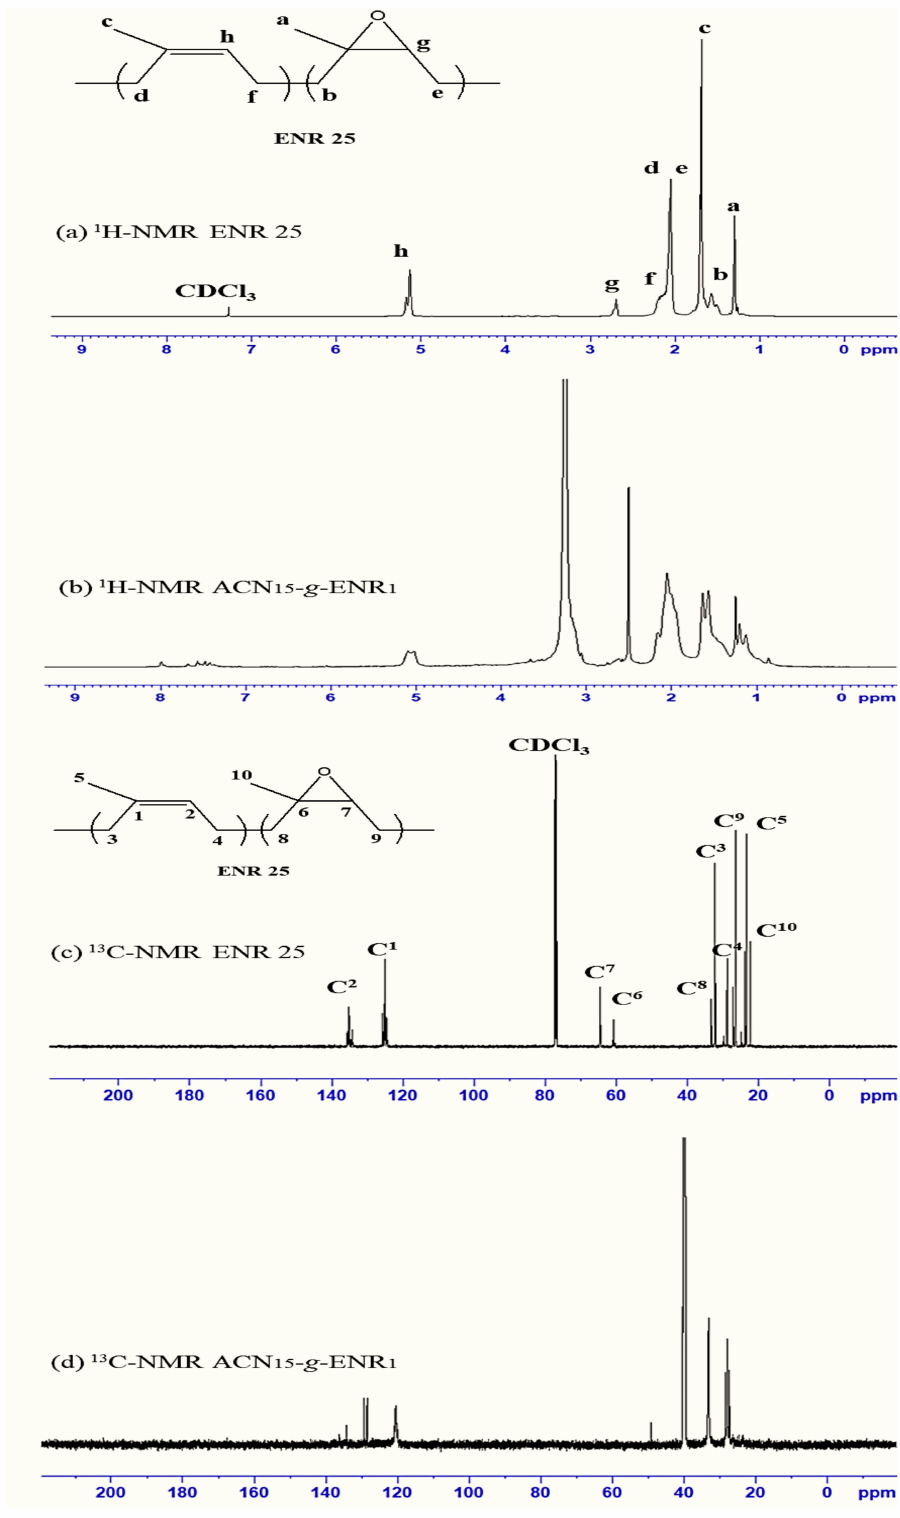
Figure 4. 1D NMR spectra for ENR 25 and ACN 15 - g -ENR 1 . ( a ) 1 H-NMR of ENR 25, ( b ) 1